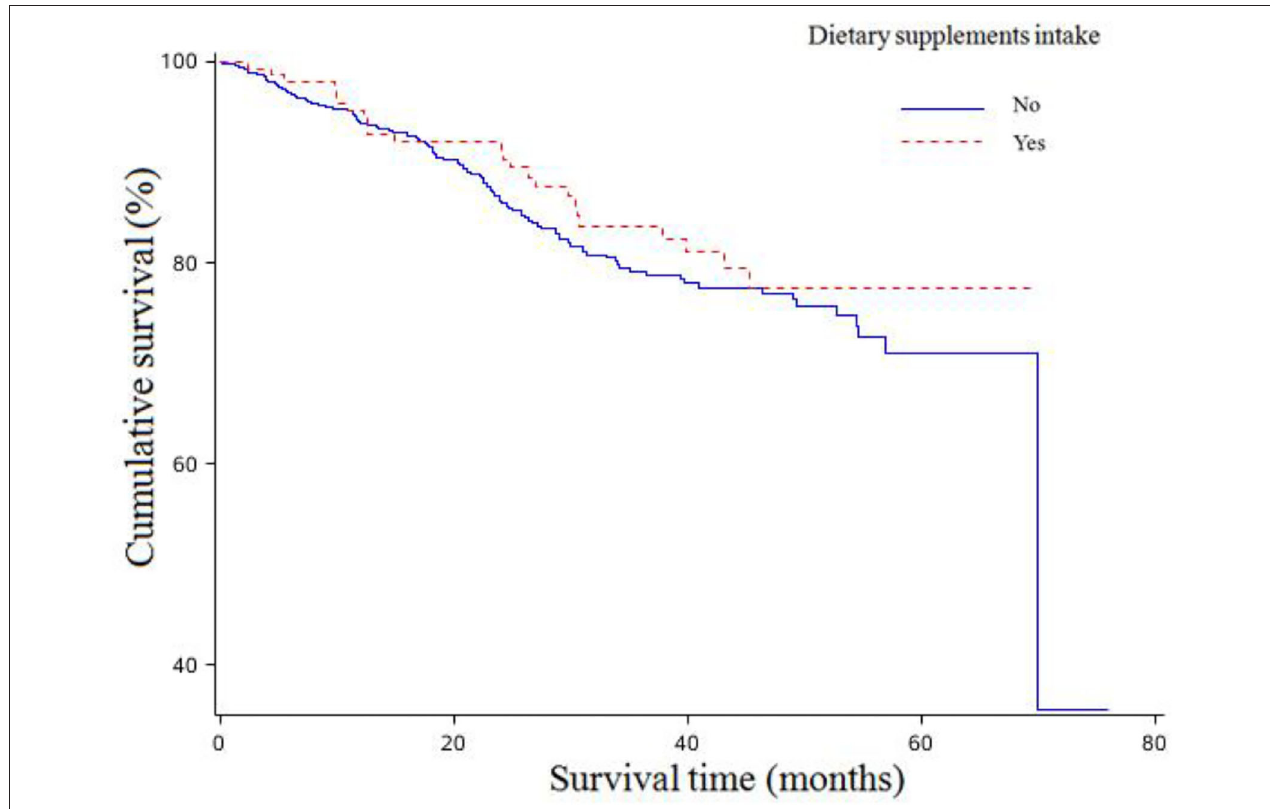
FIGURE 1 | Kaplan-Meier survival curves for dietary supplements